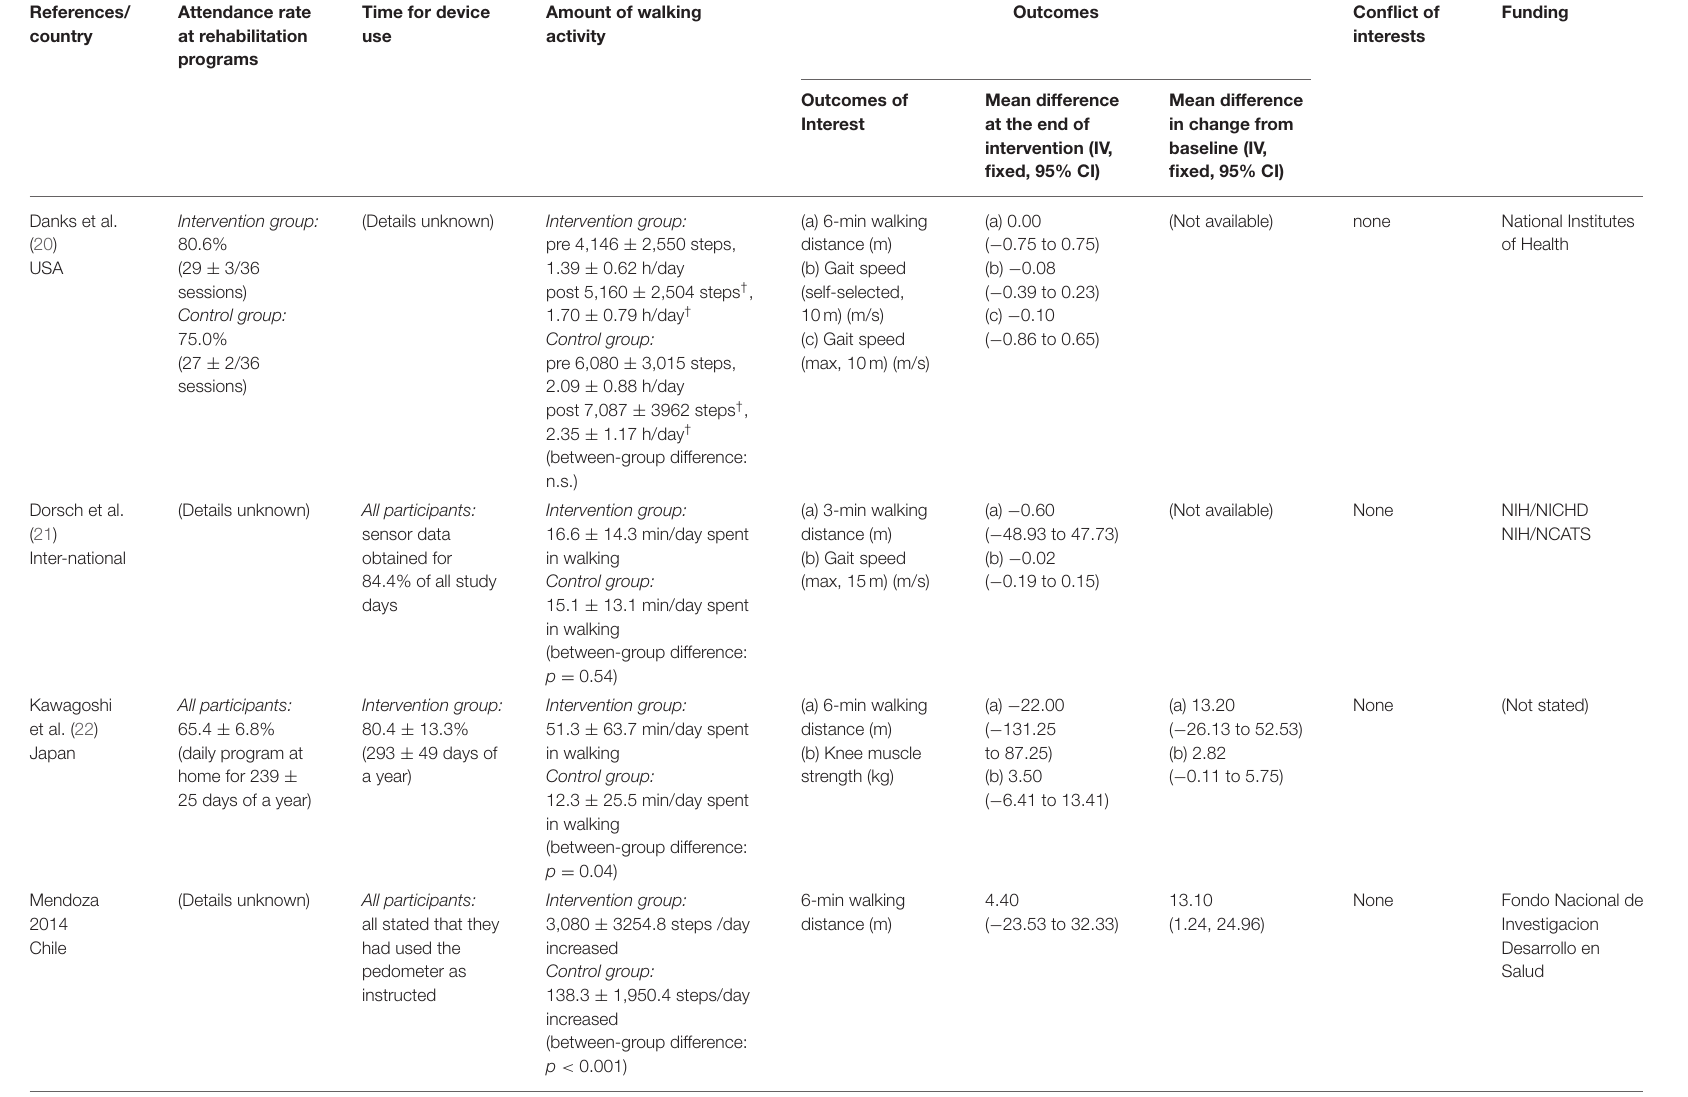
TABLE 2 | Characteristics of the included studies 2: Results and other information. References/